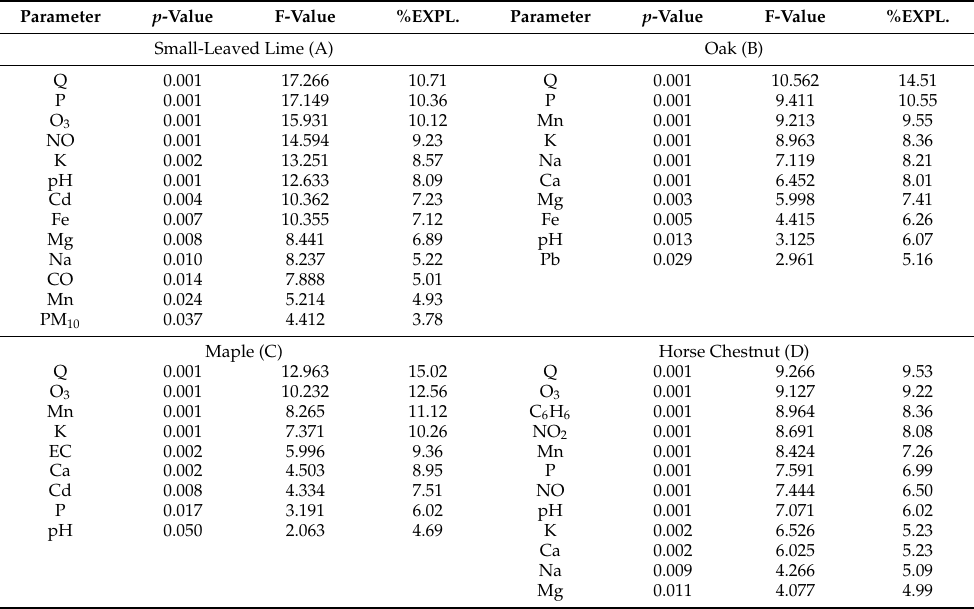
Figure 2. CCA analysis—relationships between the analyzed greenery locations (1–11) and the levels of the studied parameters in soil (green axes) and air (red axes): ( A ) small-leaved lime ( n = 121); ( B ) oak ( n = 121); ( C ) maple ( n = 121); ( D ) horse chestnut ( n = 121). Table 8. Statistical parameters for the CCA